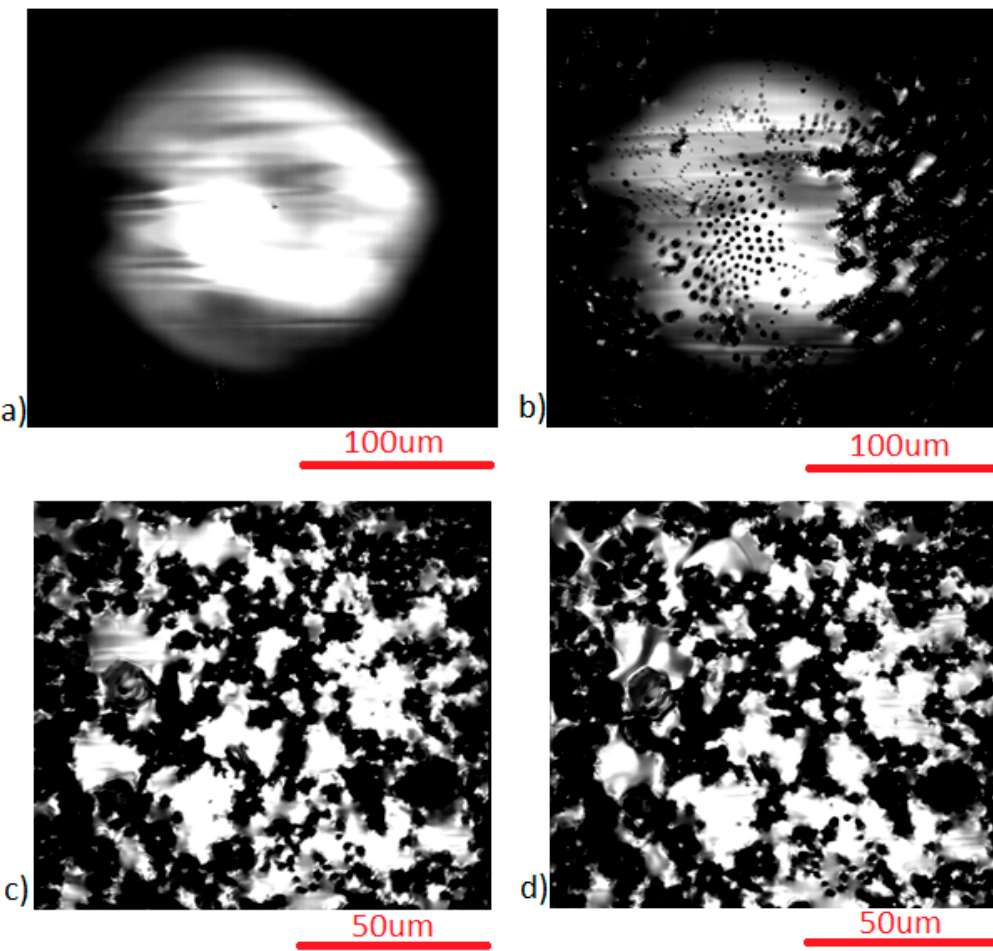
Figure 8. CSLM images taken during the solidification of steel under a N 2 atmosphere at ( a ) 0 s (liquid steel), ( b ) 10 s (graphite flake on steel surface), ( c ) 30 s (increase in graphite flakes) and ( d ) 45 s (start of solidification – dendrite interfaces arrowed).